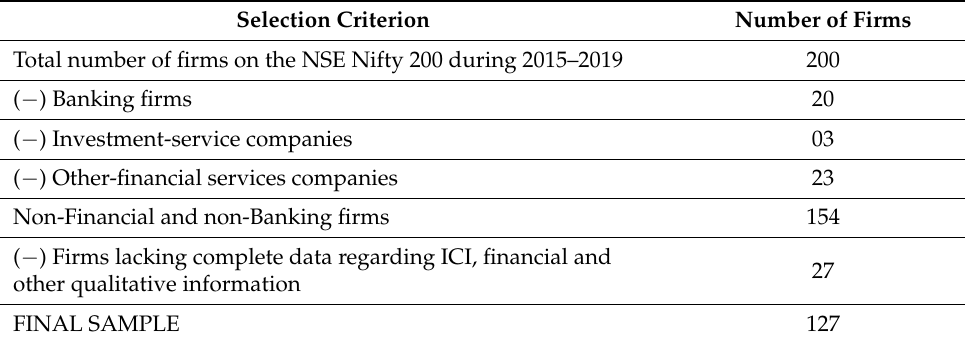
Table 2. Sample Description and